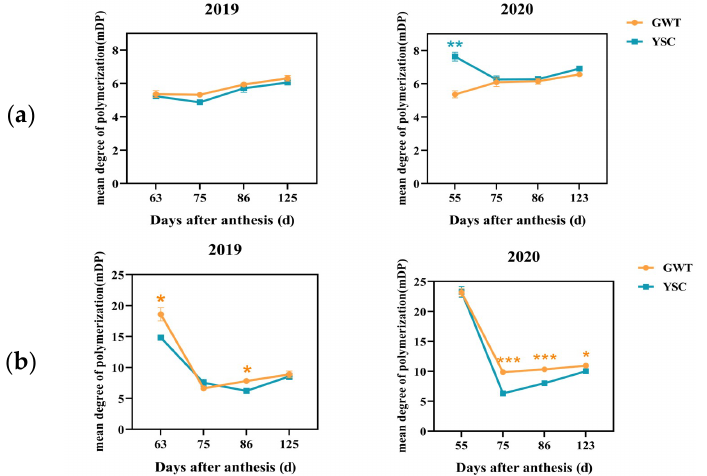
Figure 7. Changes in the mean degree polymerization of soluble ( a ) and insoluble CT ( b ) in the GWT and YSC seeds. The asterisk indicates that there is a statistical difference between the 2 vineyards in the same period at the 0.05 level: *, p < 0.05; **, p < 0.01; ***, p <